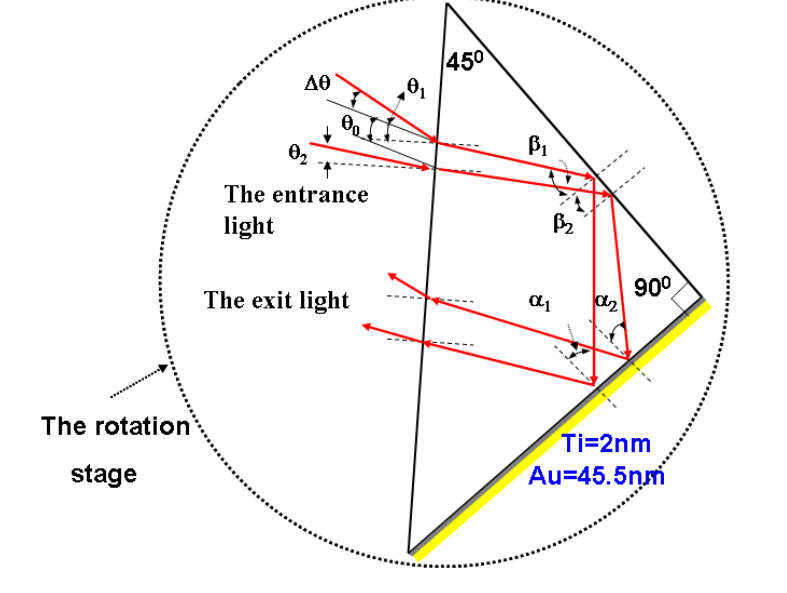
= θ + Δθ and θ = θ – Δθ , 1 0 2 0